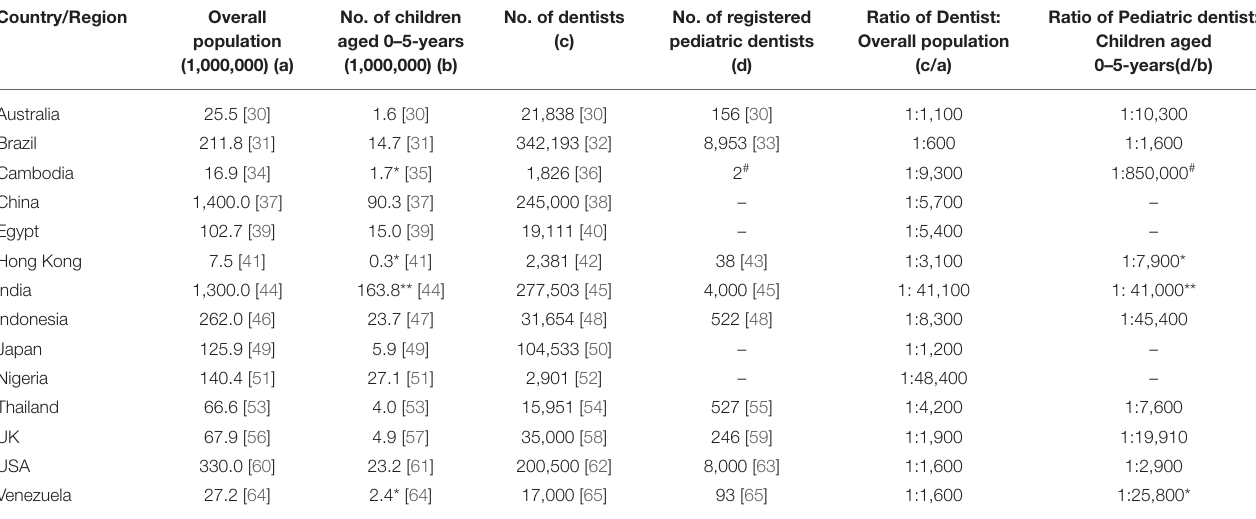
TABLE 2 | Updated dental health workforce data: number of dentists, pediatric dentists, ratio of dentist to population, and ratio of pediatric dentist to child population (aged 0–5-years).